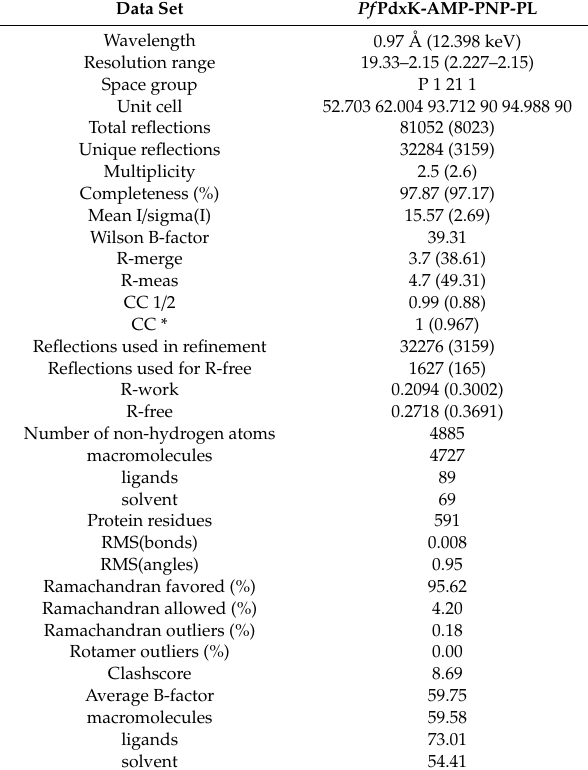
Table 1. Data collection and refinement